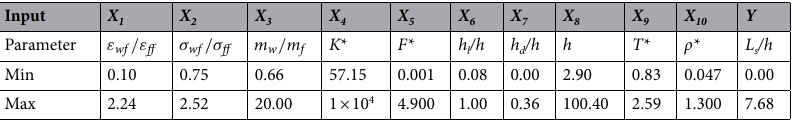
Table 1. Data set value